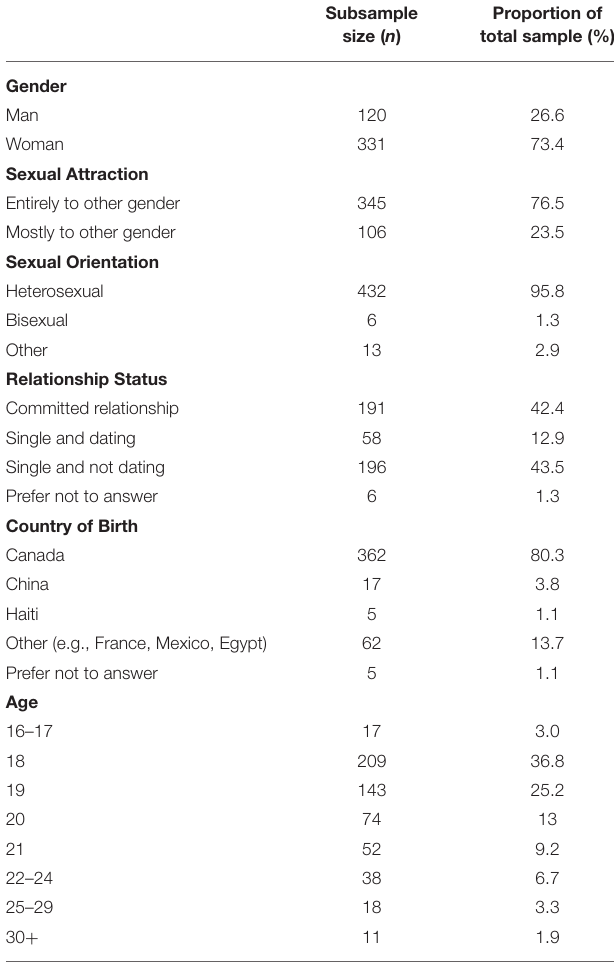
TABLE 1 | Demographic and background characteristics of sample retained for